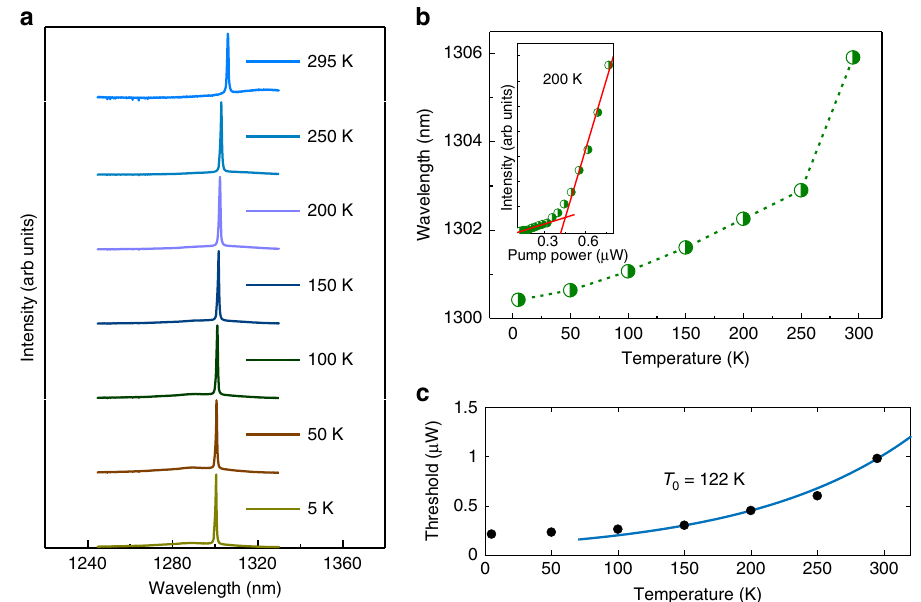
Fig. 4 Temperature dependent laser performance. a Normalised lasing spectra at the pumping power 1.6 μ W (above threshold) from 5 to 295 K. b Temperature dependence of lasing wavelength at the pumping power 1.6 μ W, the inset shows a measured L – L curve at 200 K. c Temperature dependence of the lasing threshold, and the blue line represents the exponential fi t to the experimental data (black dot).